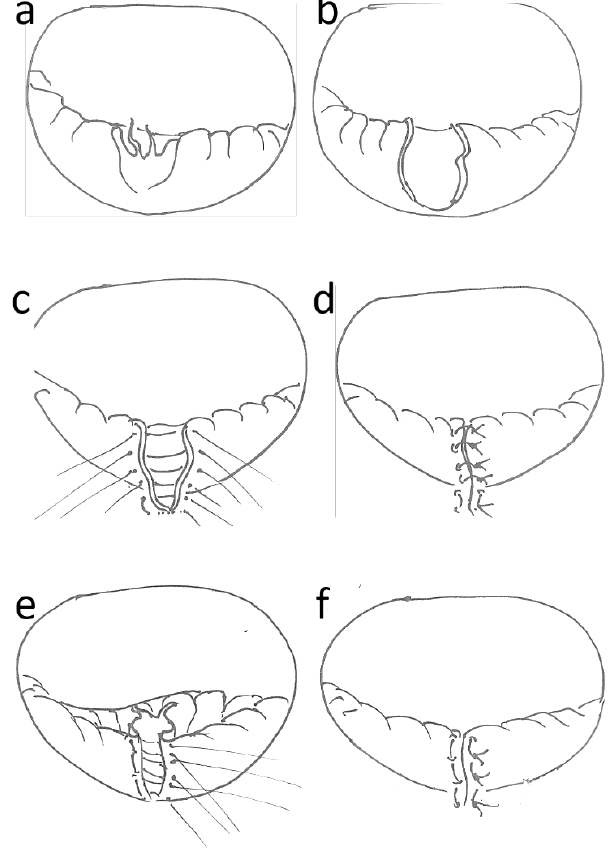
Figure 1. PML repair: ( a ): PML prolapse with severed chordae; ( b ): quadrangular resection; ( c ): suture placement (5-0 polypropylene); ( d ): result after quadrangular resection; ( e ): inversion of prolapsed leaflet and suture placement (U-stiches, 5-0 polypropylene); ( f ): results after inverse plication.